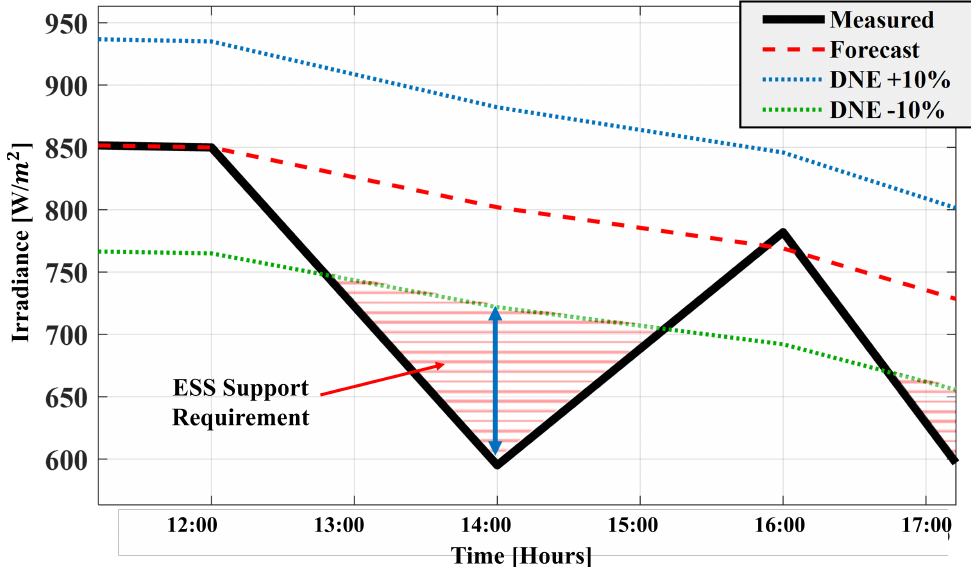
Figure 2. Operation of an energy storage system (ESS) in a dispatchable